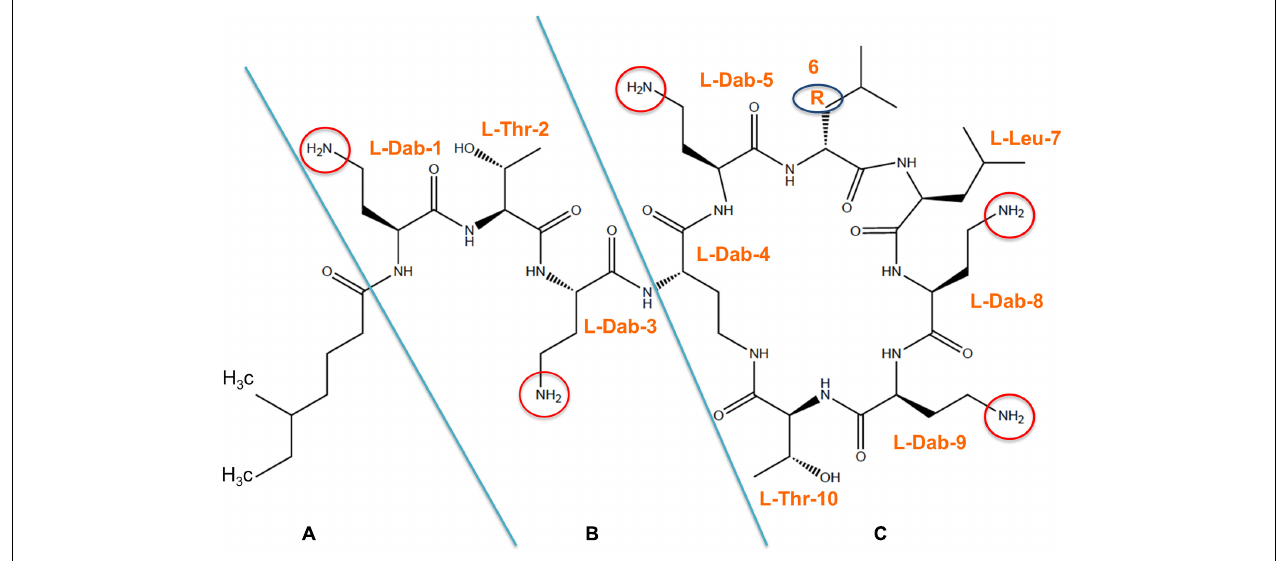
FIGURE 1 | Chemical structure of colistin is composed of three parts: (A) hydrophobic acyl tail, (B) linear tripeptide segment (C) hydrophilic, heptapeptide ring. Arabic numeral indicates the position of amino acids on the structure and the reactive amino groups are encircled. R6: D - phenylalanine in polymyxin B or D - leucine in polymyxin E